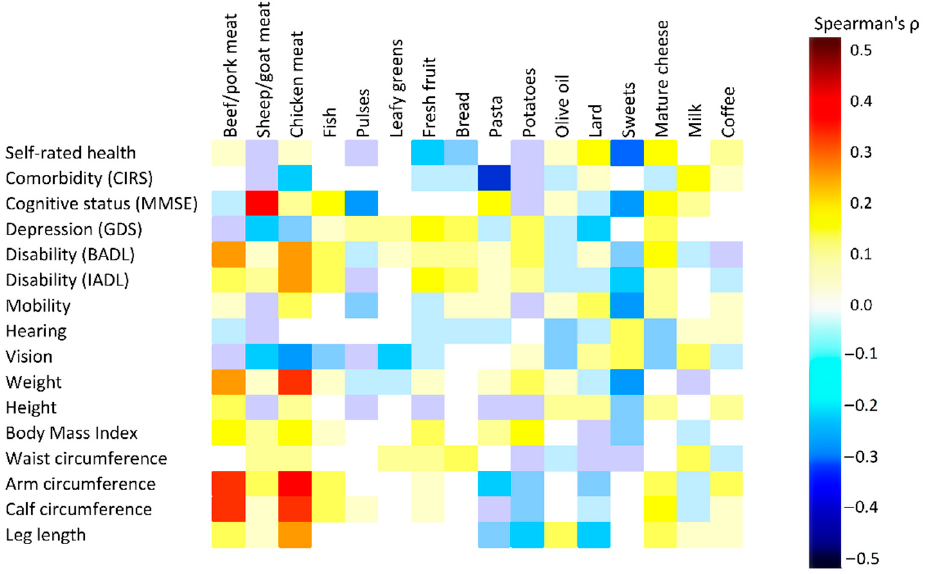
Figure 3. Spearman correlation heat map for the association between food frequency and health indicators.